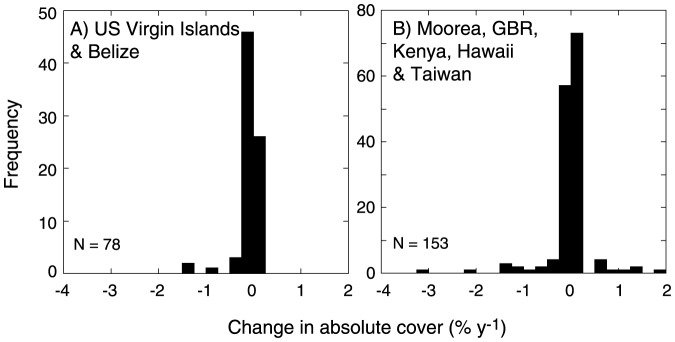
Frequency distributions of changes in absolute coral cover by genus between 1987 and 2012 (two Caribbean sites) and 1987 and 2013 (five Indo-Pacific sites).(A) US Virgin Islands and Belize, and (B) Moorea, Hawaii, Taiwan, the Great Barrier Reef, and Kenya; sample sizes (n) shown in all panels. See http://knb.ecoinformatics.org/knb/metacat/nceas.973/knb for raw data, and Table S3 for changes in coral abundances described by these distributions.